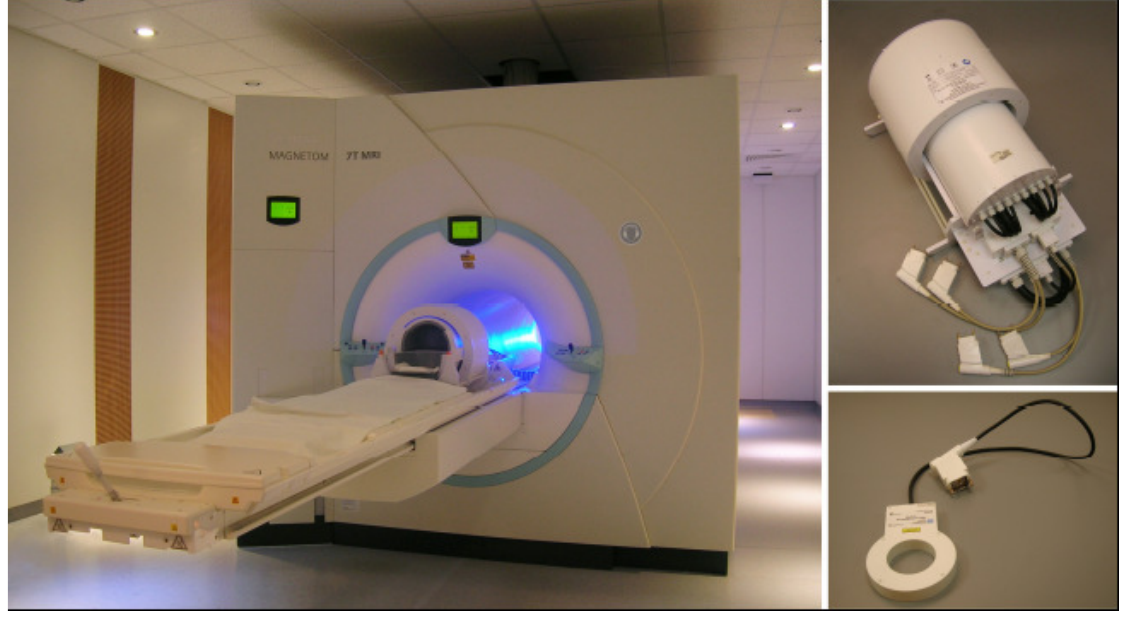
Figure 13. Ultra-high field whole body MR scanner Siemens Magnetom 7 T (left) with 24-channel (transmit-) receive coil (by Nova Medical) placed on the patient bed. B gradient-coils are installed in the scanner bore. The 24-channel Rx head coil (top right) is equipped with a transmit coil (outer cylinder), tuned to 300 MHz (Larmor frequency of 1 H at 7 T). Single-loop transmit/receive surface coil by RAPID Biomedical (bottom